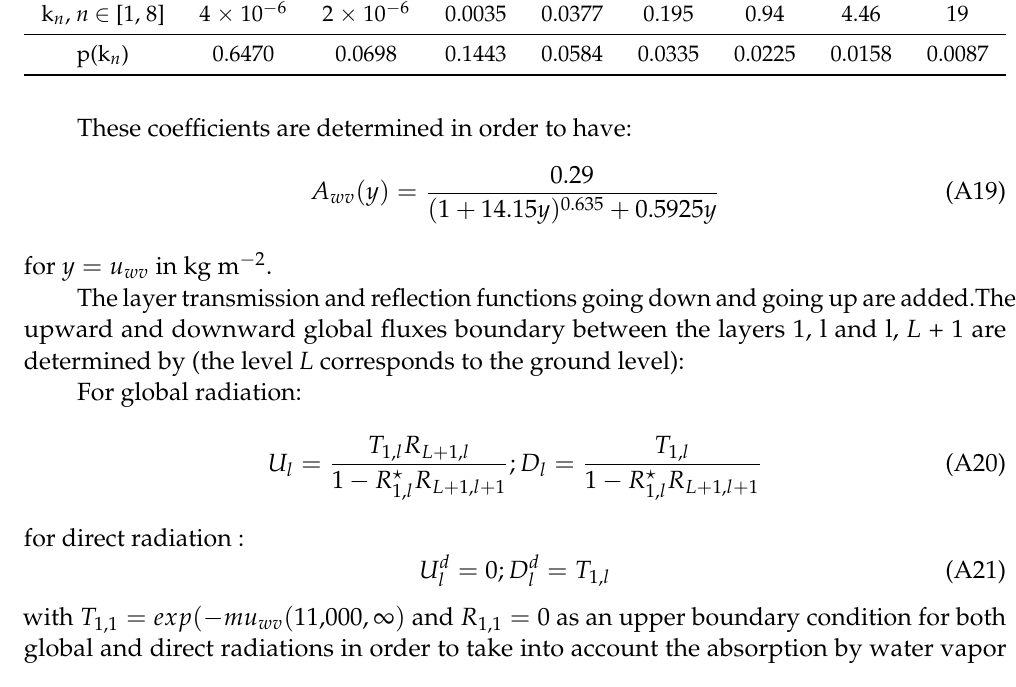
Table A1. Discrete probability distribution of water vapor absorption coefficients for n = 1, 8 (LH74). k n , n ∈ [1, 8] 4 × 10 −